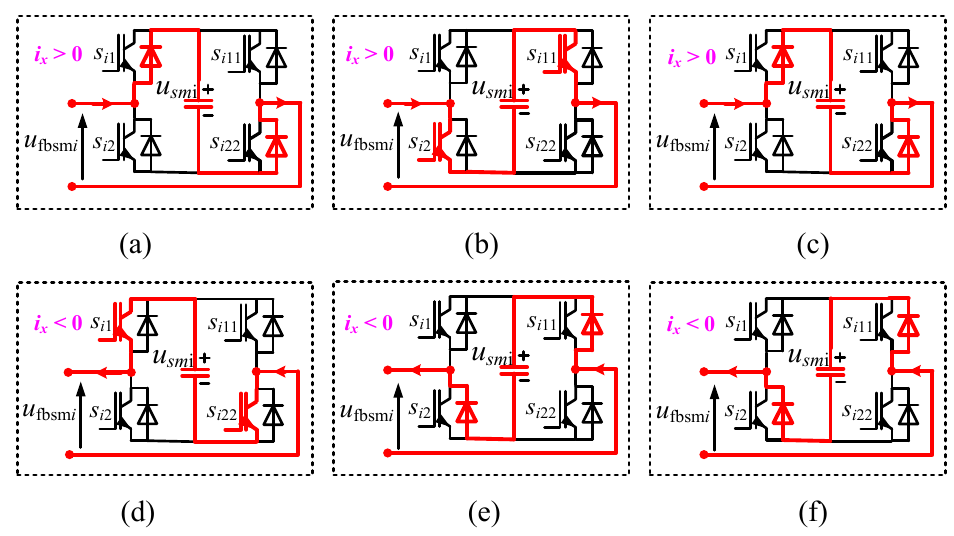
Figure 4. Basic operation mode of FBSM in the hybrid MMC: ( a ) i x > 0, S i 1 = S i 22 = 1, S i 2 = S i 11 = 0; ( b ) i x > 0, S i 1 = S i 22 = 0, S i 2 = S i 11 = 1; ( c ) i x > 0, S i 1 = S i 22 = 0, S i 2 = S i 11 = 0; ( d ) i x < 0, S i 1 = S i 22 = 1, S i 2 = S i 11 = 0; ( e ) i x < 0, S i 1 = S i 22 = 0, S i 2 = S i 11 = 1; ( f ) i x < 0, S i 1 = S i 22 = 0, S i 2 = S i 11 = 0.